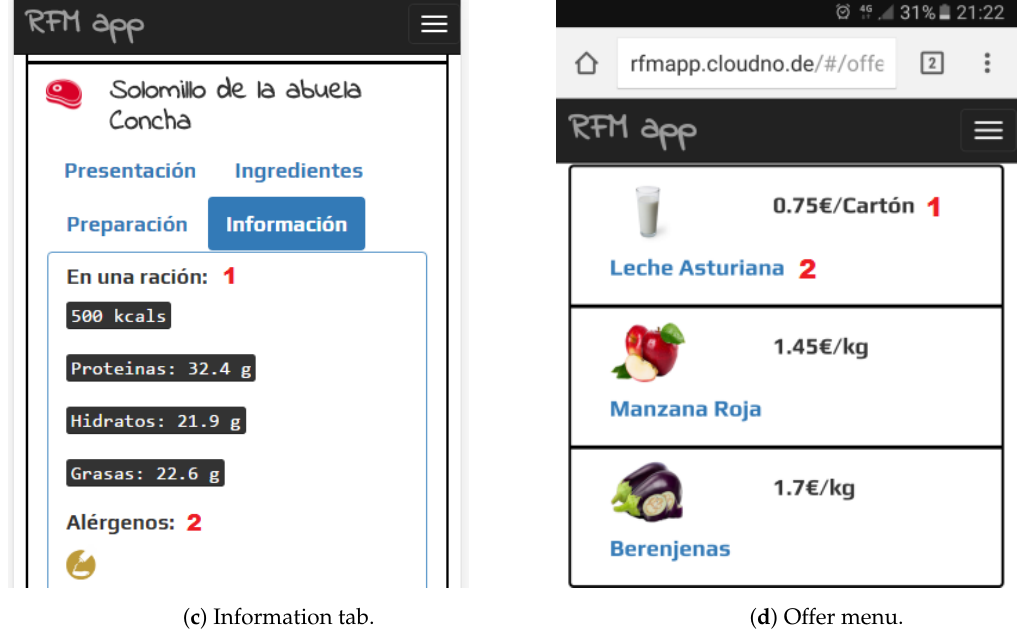
Figure 5. Recipe and Offer menu complete the RFM